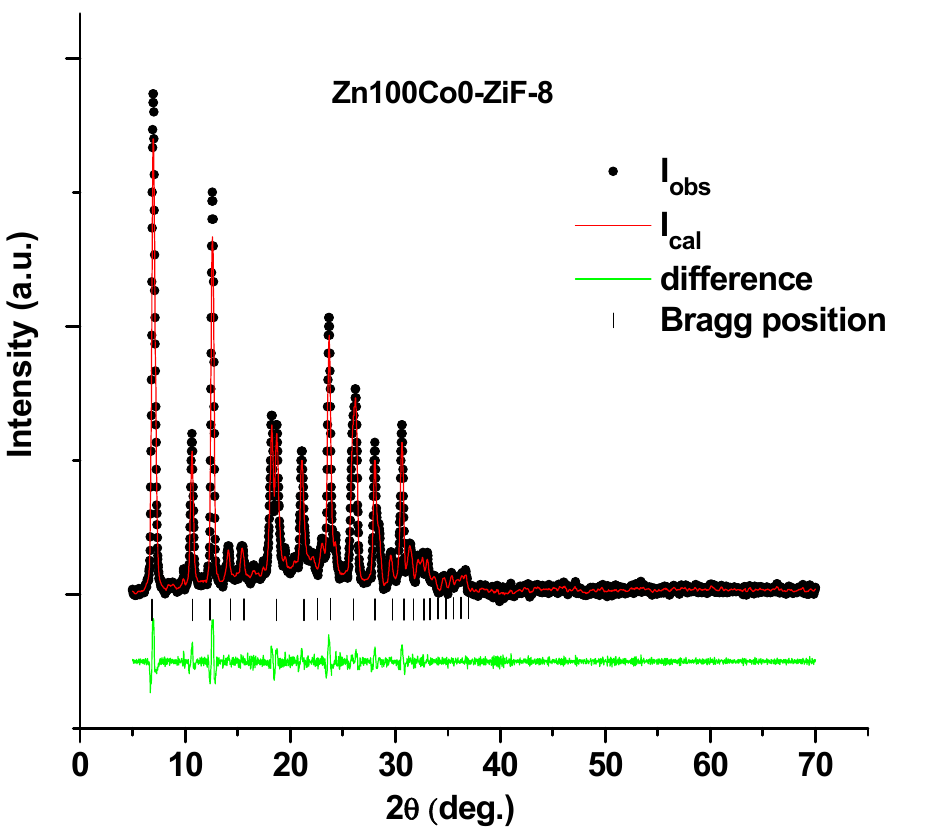
Figure 5. X-ray diffractograms of the Zn100Co0-ZIF-8 sample with Rietveld refinement. Table 1. The lattice parameters, cell volume, and phase ratios of Zn 1-x Co x -ZIF-8. Samples (640 ◦